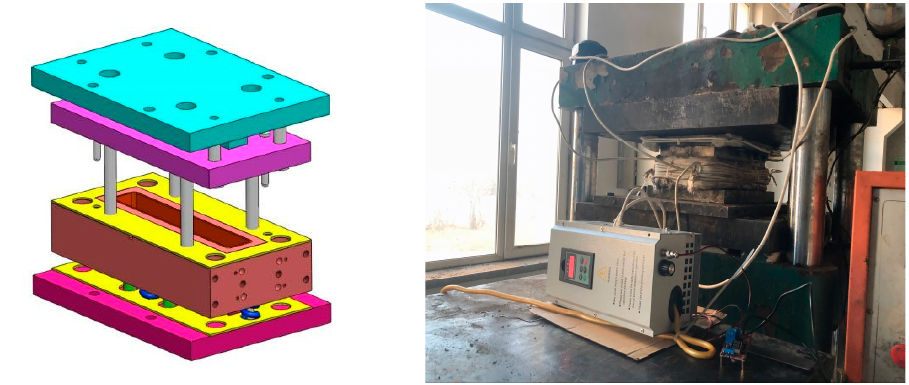
Figure 2. Compression mold for seedling trays.